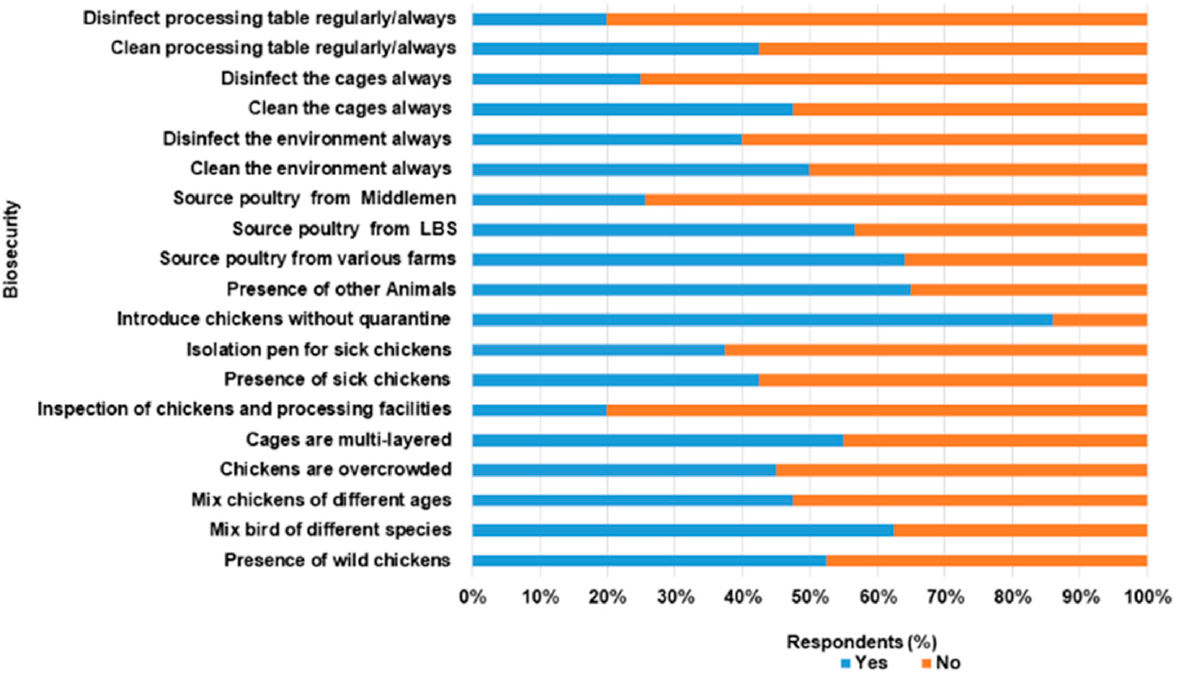
Figure 3. Biosecurity practices among Live bird Sellers in Abeokuta, Ogun State .